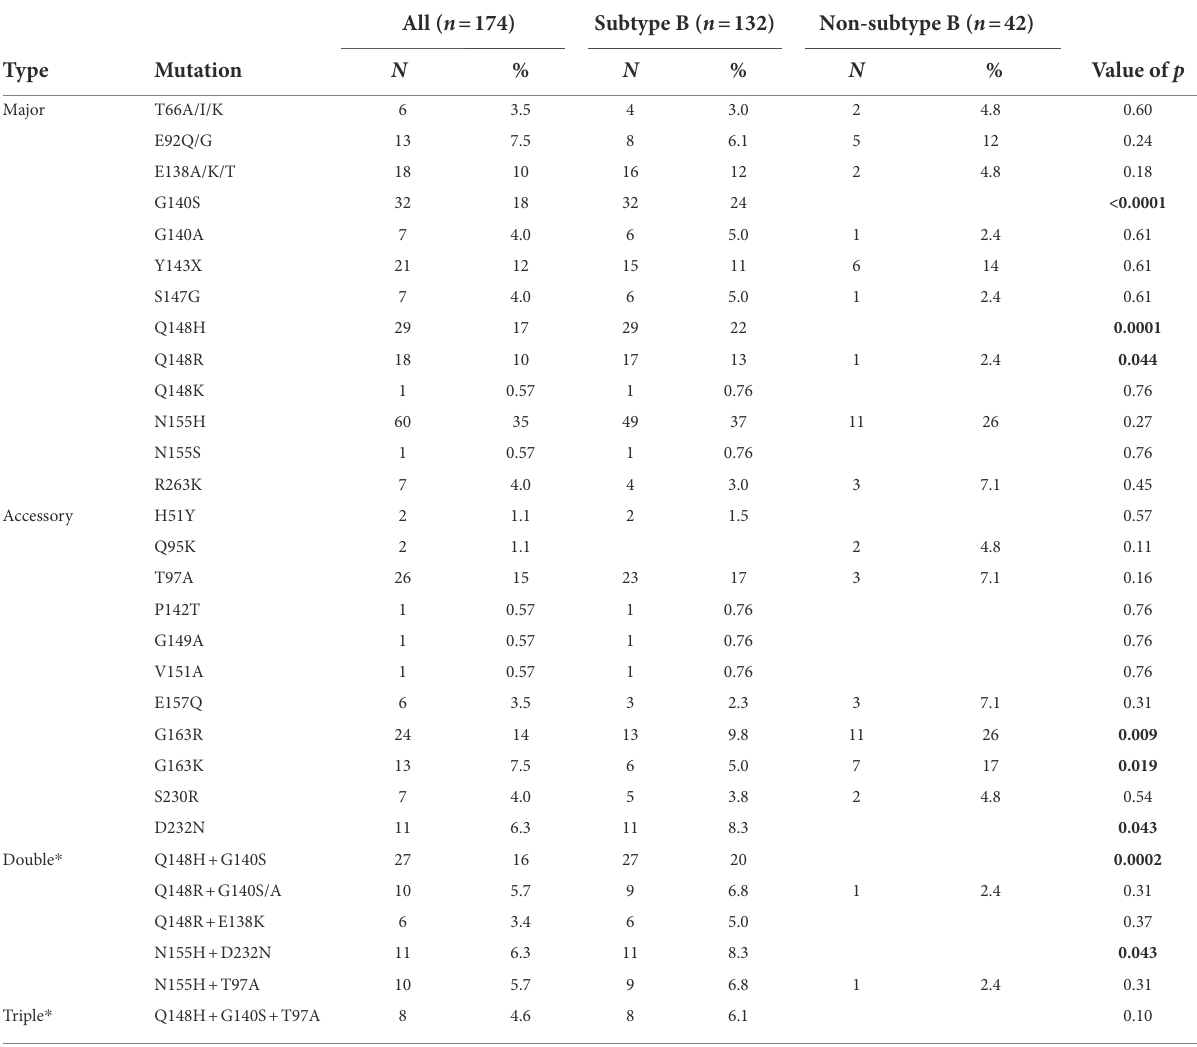
TABLE 5 Drug resistant mutations found in subtype B and non-subtype B